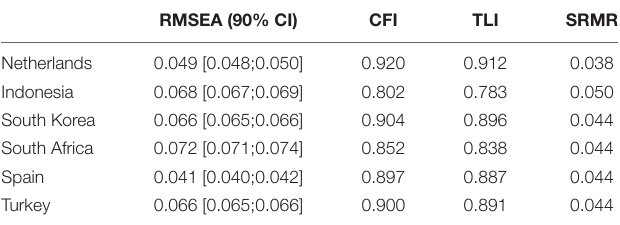
TABLE 5 | Confirmatory Factor Analysis (CFA) on the selected theoretical model (including correlated